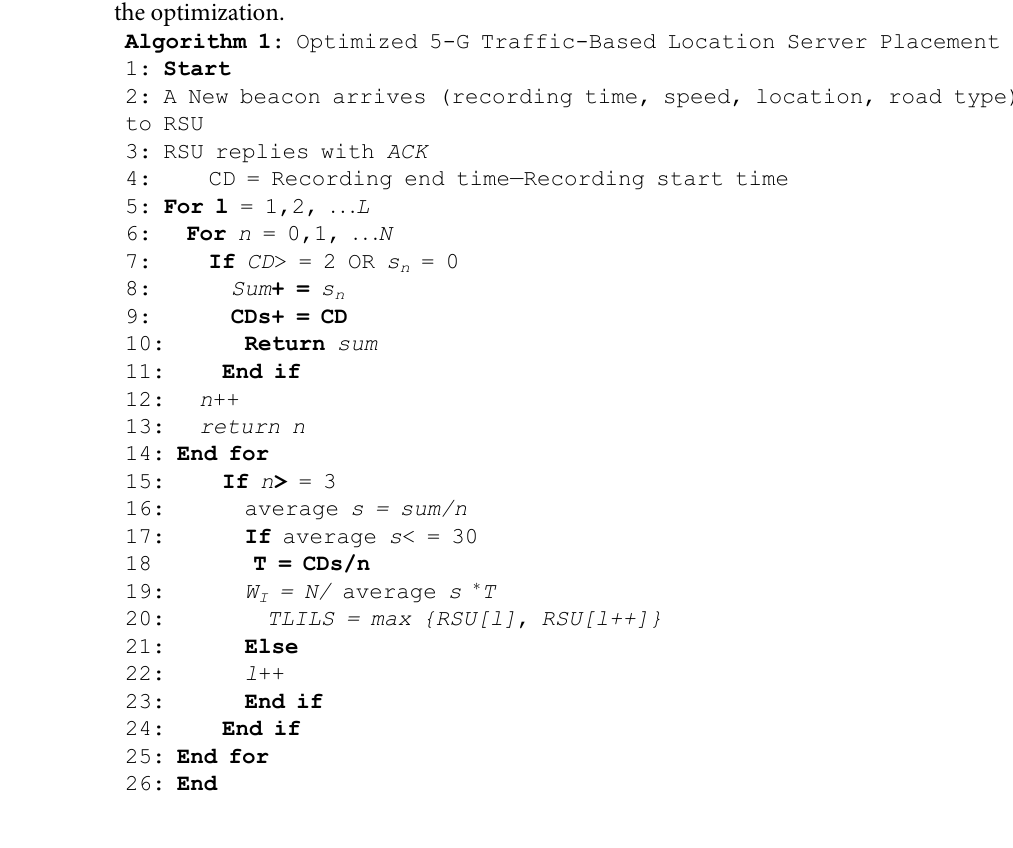
Algorithm 1 : Optimized 5-G Traffic-Based Location Server Placement